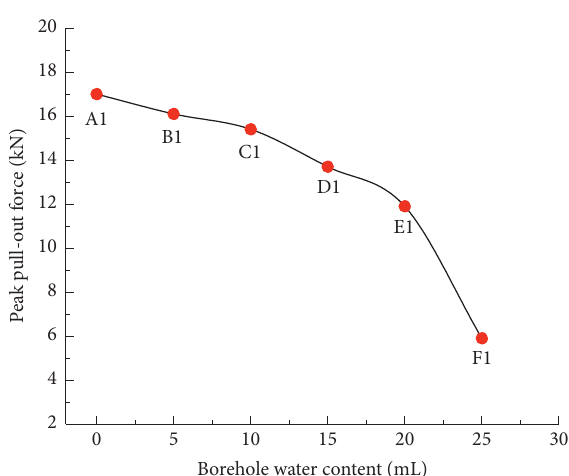
Figure 7: Point line diagram of maximum loading of specimens with different water